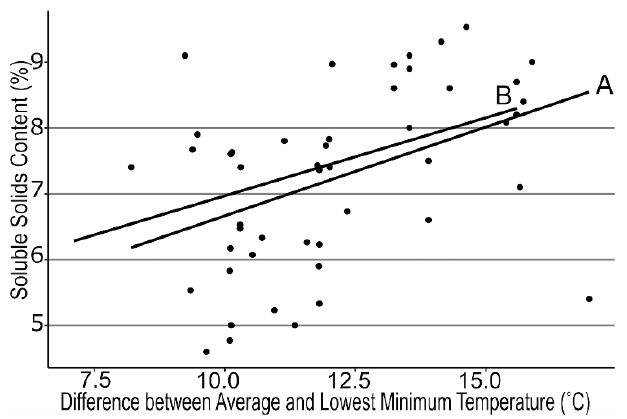
Figure 3. Regression between final soluble solids content of strawberry fruit at harvest and the difference between mean air temperature and the lowest single temperature between first flower and green fruit (A) and green to pink fruit (B) for 16 farms across New York State visited in 2018, 2019, and 2020. A: y = 0.27x + 4.0, r = 0.43, p < 0.005. B: y = 0.24x + 4.6, r = 0.36, p < 0.05.